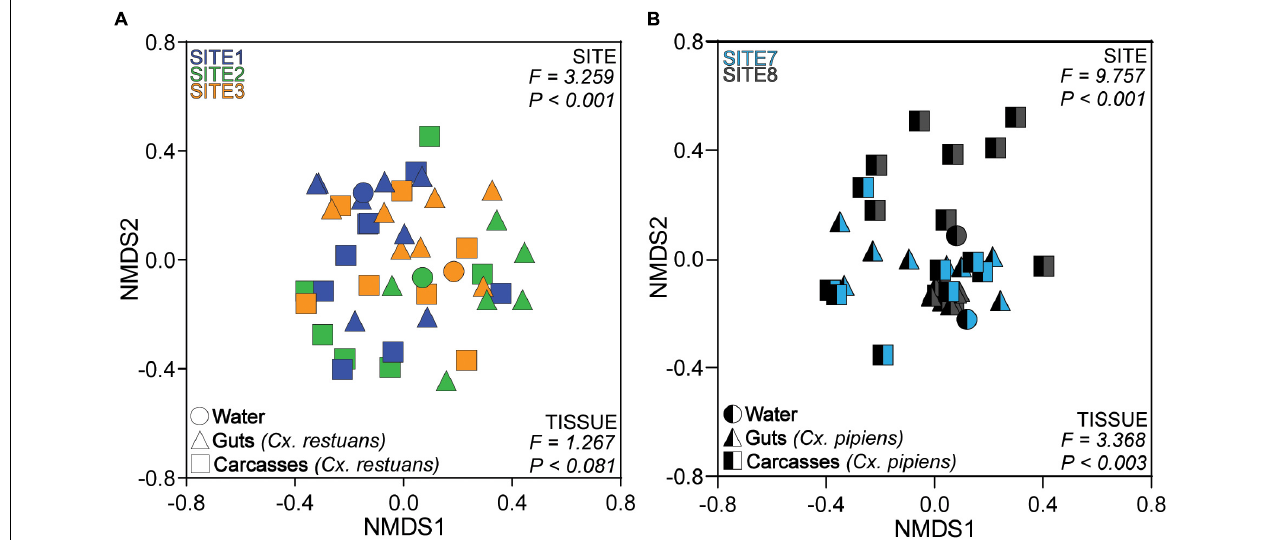
FIGURE 3 | Non-metric Multidimensional Scaling (NMDS) ordination of the Bray-Curtis dissimilarity distances across larval breeding water and mosquito guts and carcasses. (A) NMDS of Bray-Curtis dissimilarity distances across Cx. restuans breeding water and guts and carcasses. (B) NMDS of Bray-Curtis dissimilarity distances across Cx. pipiens breeding water and guts and carcasses. The keys at the top left of each plot indicate the color designated to each larval breeding site, while the keys at the bottom left designate the shapes associated with each sample type. Samples cluster significantly by site as presented by the PERMANOVA results at the top right of each plot. Samples also cluster by tissue type as indicated by the PERMANOVA results at the bottom right of each plot.